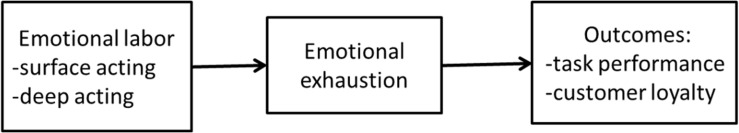
Theoretical model.